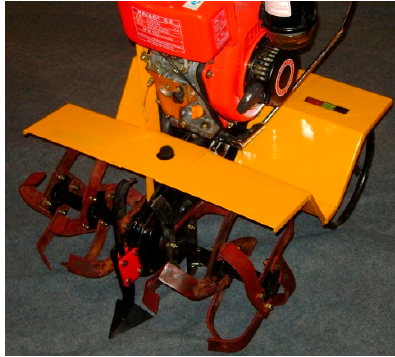
Figure 4. Datang 2 WT with rotary cultivator. (Photo: Brian Sims).